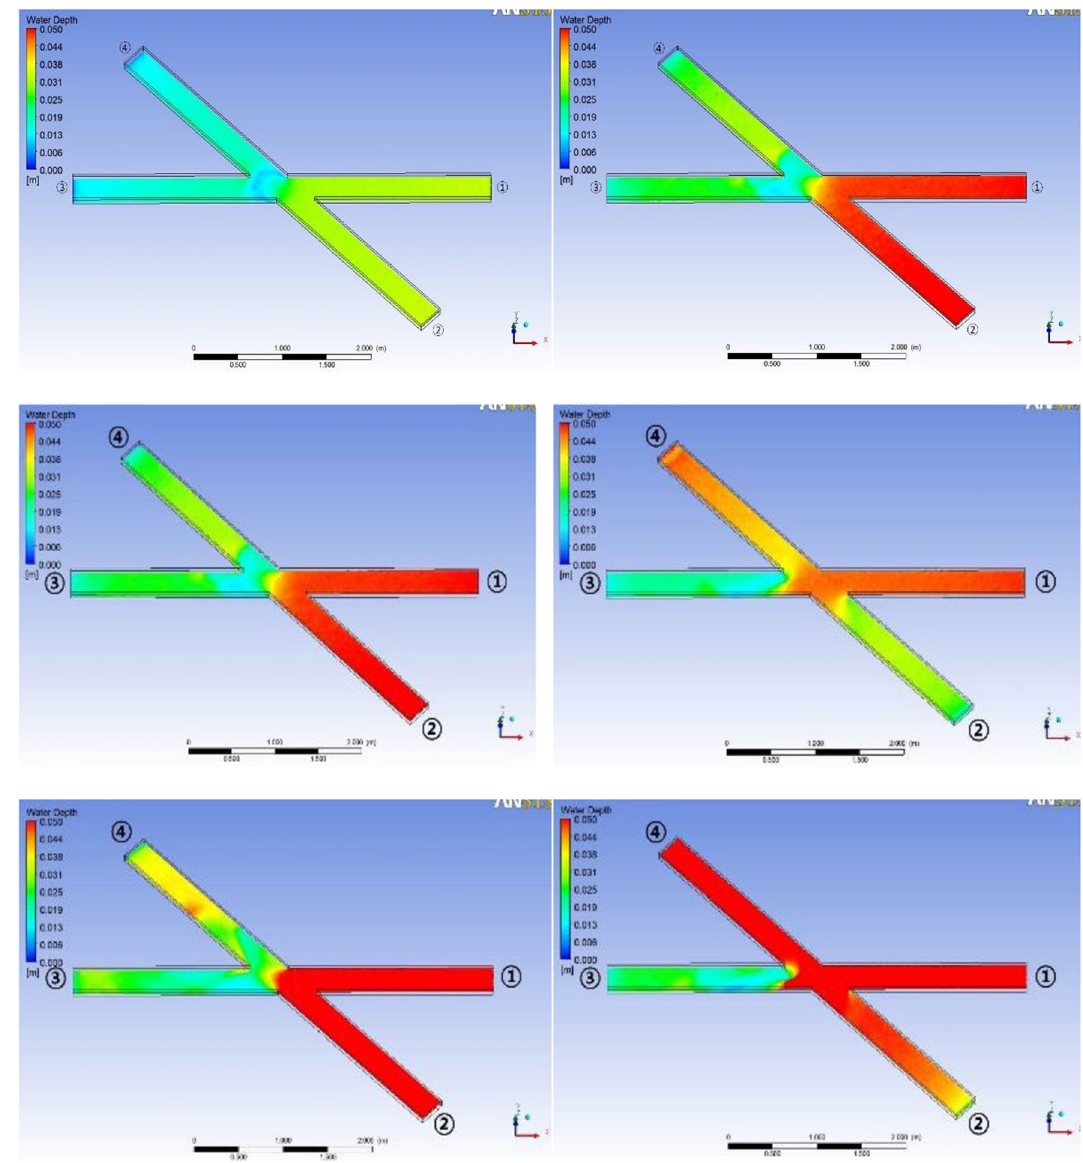
Fig. 11 Comparison of water-surface profiles along channels with increased inflow for Case I and